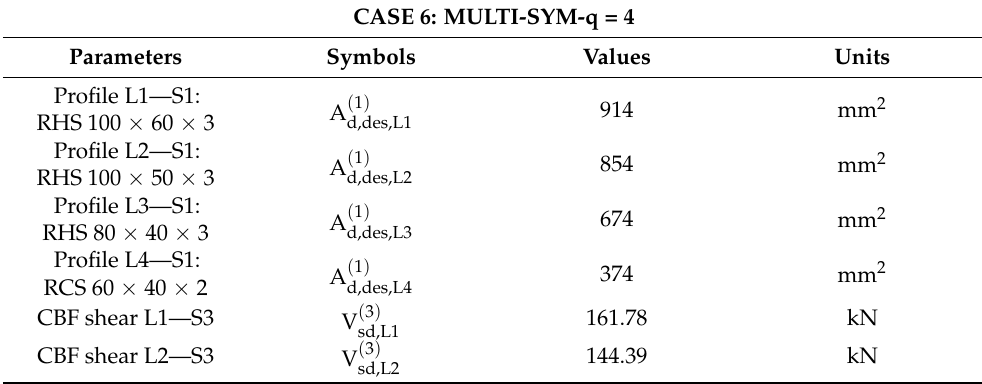
Table 12. Loads applied to the multi-storey case studies. Table 15. Results of case study 6 (L: level; S: